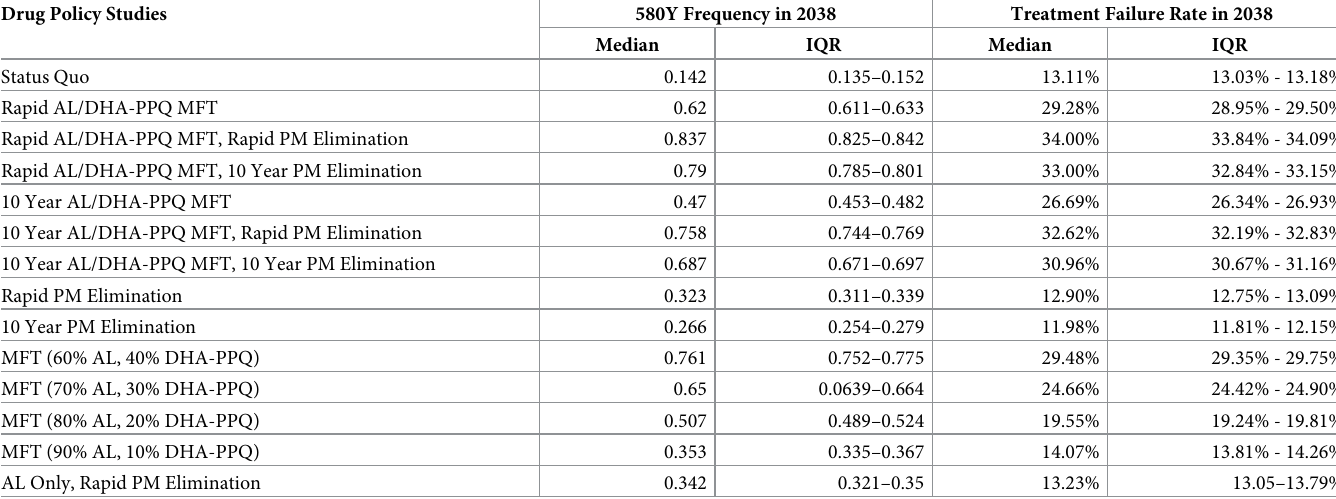
Table 1. Drug policies examined in this study. Note that all policy interventions result in a higher 580Y frequency compared to the status quo scenario, but this may be offset by reductions in the treatment failure rate for some policies. Note that the MFT scenarios assume rapid private market (PM) elimination and that unless otherwise specified the MFT is 50% AL and 50% DHA-PPQ.